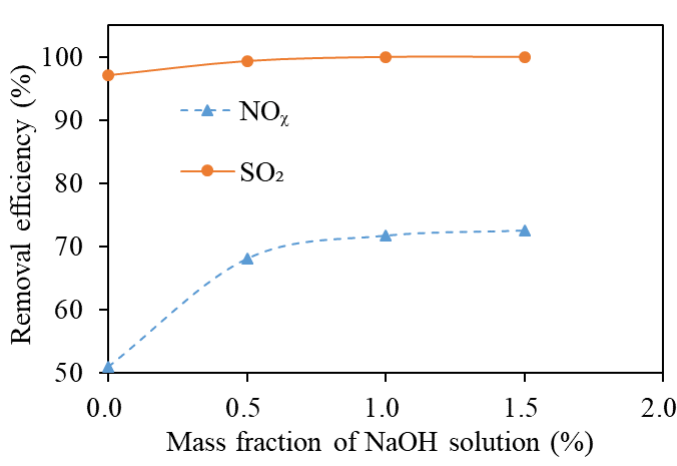
Figure 8. The desulfurization and denitration efficiency levels at various mass fractions of the NaOH solution (operating conditions: discharge power = 19.5 W, the gas flow rate = 5 L/min, spray density = 7.6 m 3 /(m 2 ∙ h), packing type = D g 6 mm Dixon ring, packing height = 80 cm).